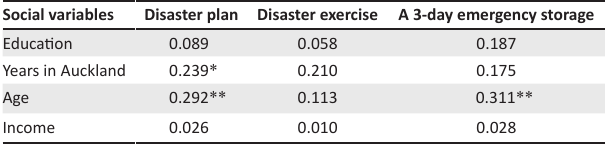
TABLE 8: Summary of the correlation between social variables and pre-disaster preparedness activities.